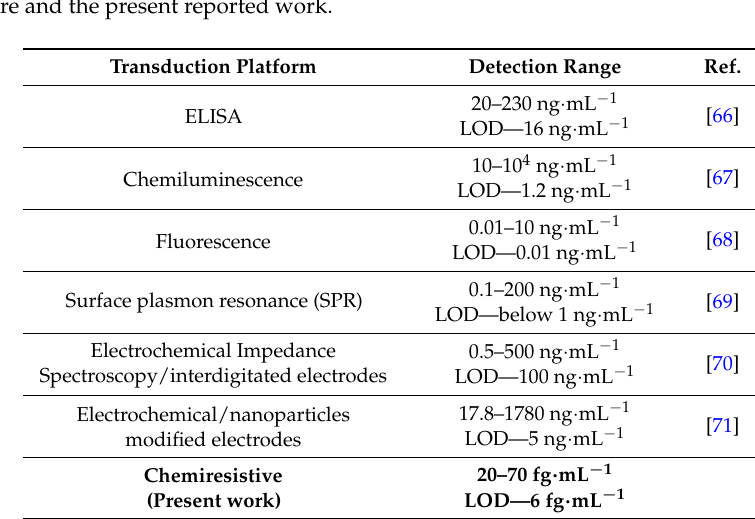
Figure 10. Myoglobin in broad detection range performance. ( a ) Linearity range of Nanobiosensor for myoglobin: 20–70 fg/mL. Table 1. Myoglobin detection on different transduction platforms and their detection range reported in the literature and the present reported work.